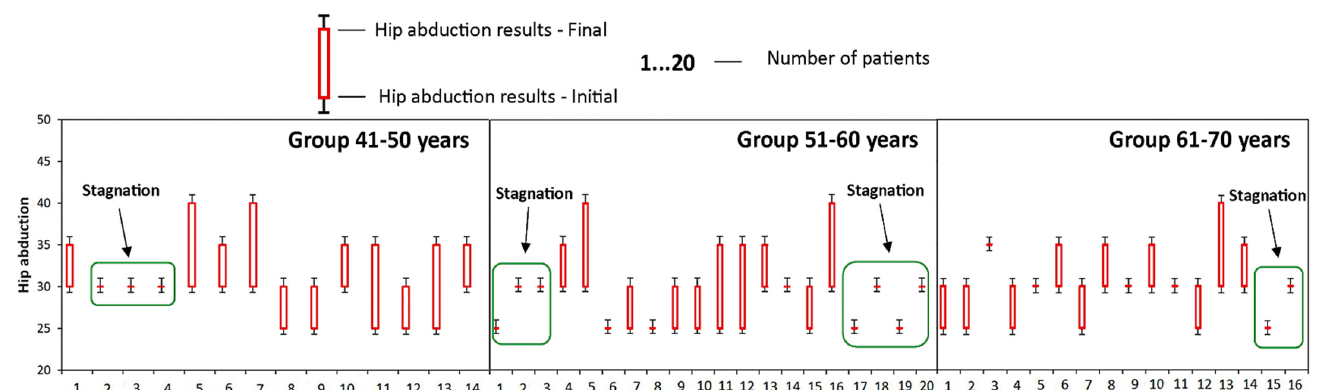
Figure 6. Evolution of hip abduction during the study at the group A. Stagnation—the value of the